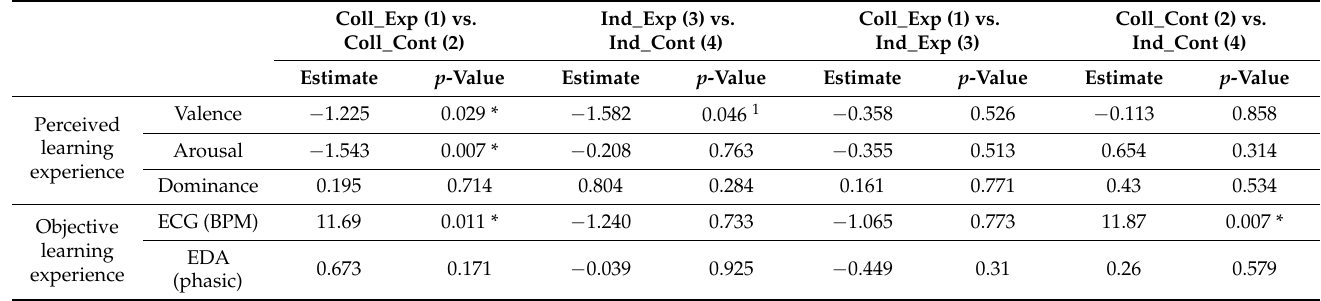
Table 3. Impact of immersion and collectivity on learning experience.